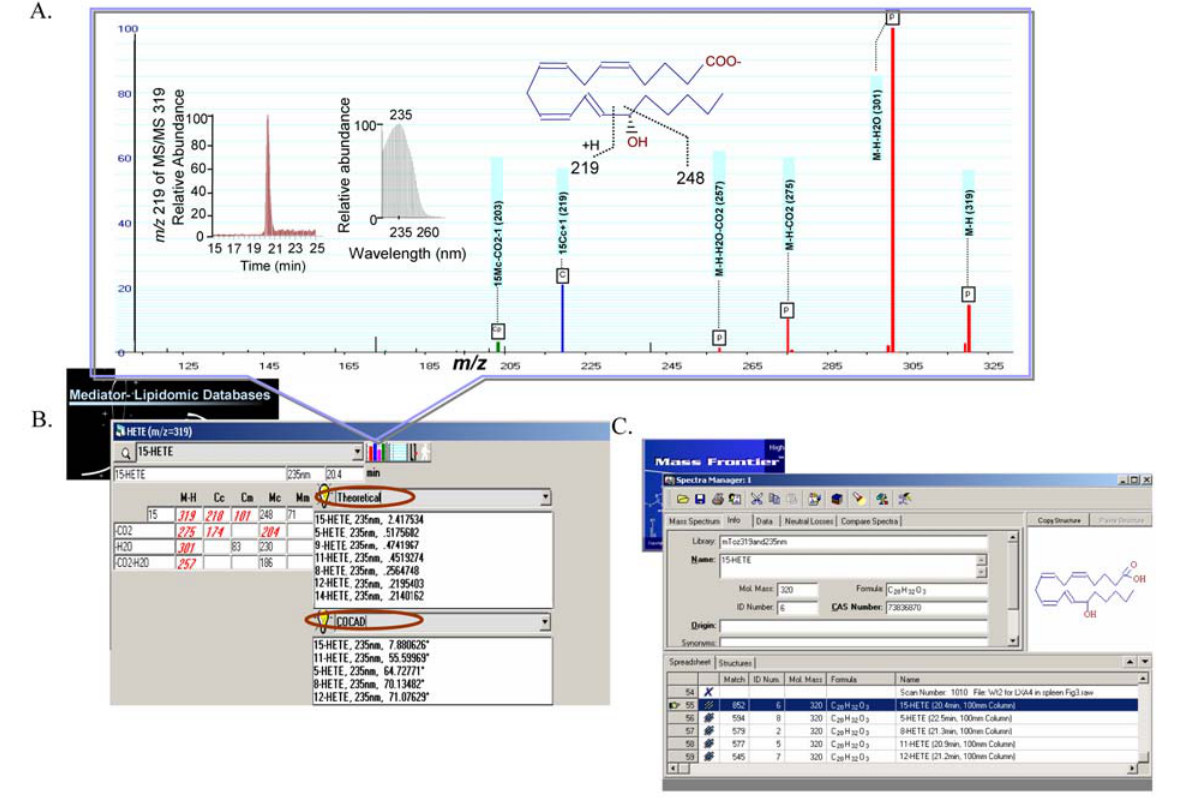
FIGURE 7. Using a computer-based automated system equipped with databases and newly devised searching algorithms developed in this lab indicated the presence of 15 S -HETE in murine spleen[2]. (A) Identification and interpretation of anions in a MS/MS (at m/z 319) spectrum. The MS/MS scan conditions were: parent ion, m/z 319; isolation width, 1.5; normalized collision energy, 42%; activation time, 30 ms; and scan of MS/MS ions, from m/z 95–323. C, chain-cut ion; CP, chain-plus-peripheral-cut ion; and P, peripheral-cut ion. Insets are for identified 15 S -HETE in the sample: left , chromatogram (at m/z 219 of MS/MS 319), which was the intensity temporal profile or selective ion chromatogram at m/z 219 in MS/MS spectrum of parent ion m/z 319 generated in ESI; middle , UV spectrum showing maximal absorption at 235 nm; right , the proposed MS/MS segments on 15 S -HETE. The LC column was 100 mm long. (B) Report for the search via the Theoretical system shows 15-HETE has the highest matching score; report for the search via COCAD shows 15-HETE has the smallest contrast angle. (C) 15-HETE also had the highest matching score when the LC-UV-MS/MS data were searched against the database built with MassFrontier TM